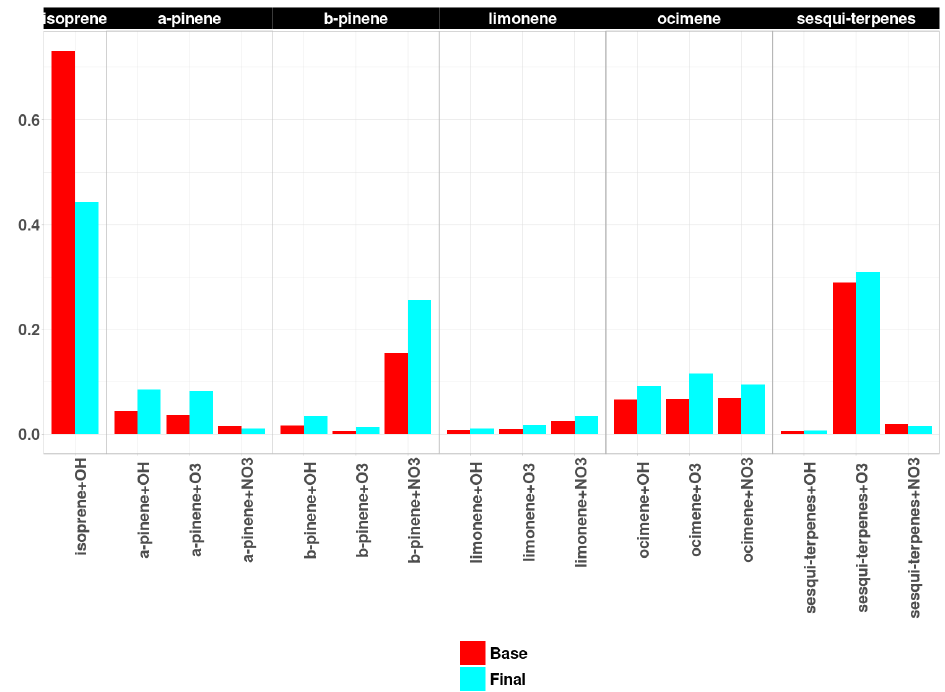
Figure 11. Bar plots showing the formation of BSOA averaged over the campaign period (in µgm − 3 ) from all precursors and oxidants. The colors of the bars indicate which simulation they are from. The reactions are shown on the x